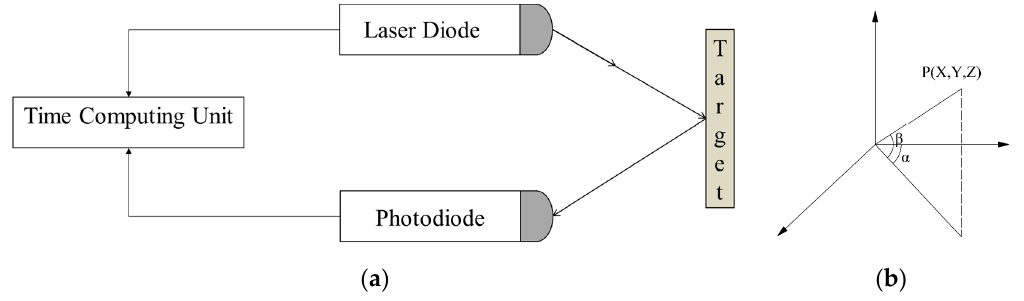
Figure 3. Schema of propagation time ranging method and internal coordinate system of laser detector. ( a ) schema of propagation time ranging method; ( b ) the internal coordinate system of laser